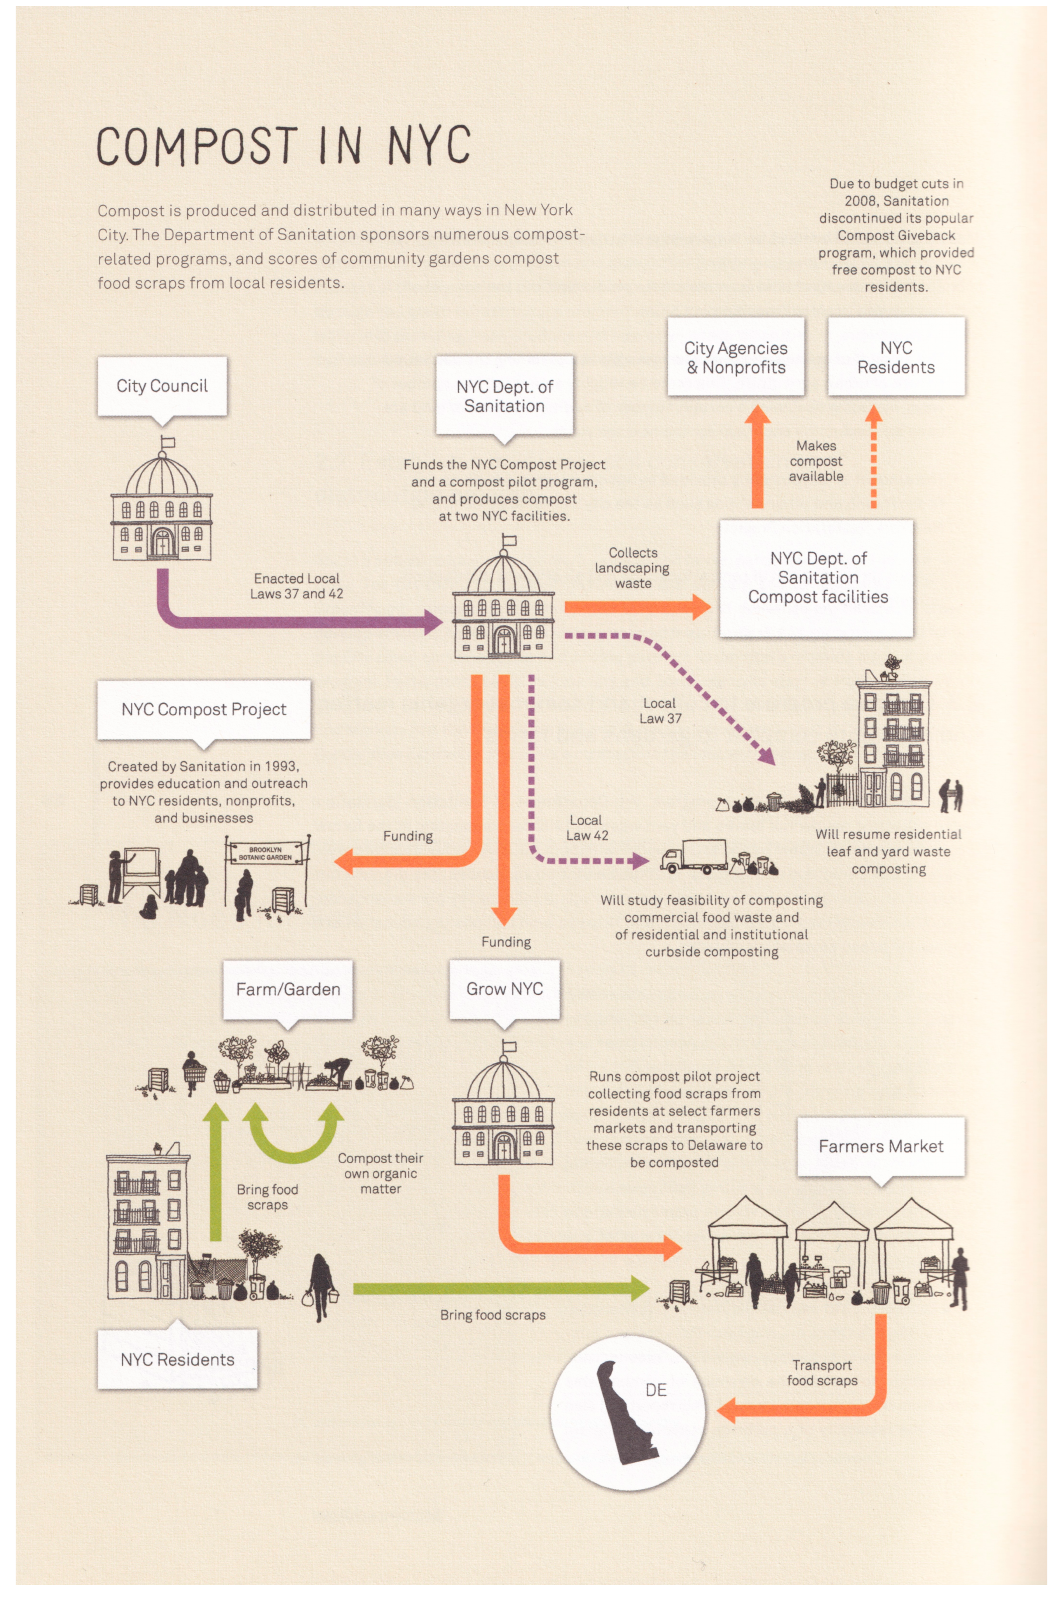
Figure 9. Compost system in New York City as analyzed in the Five Borough Farm project. Image courtesy of the Design Trust for Public